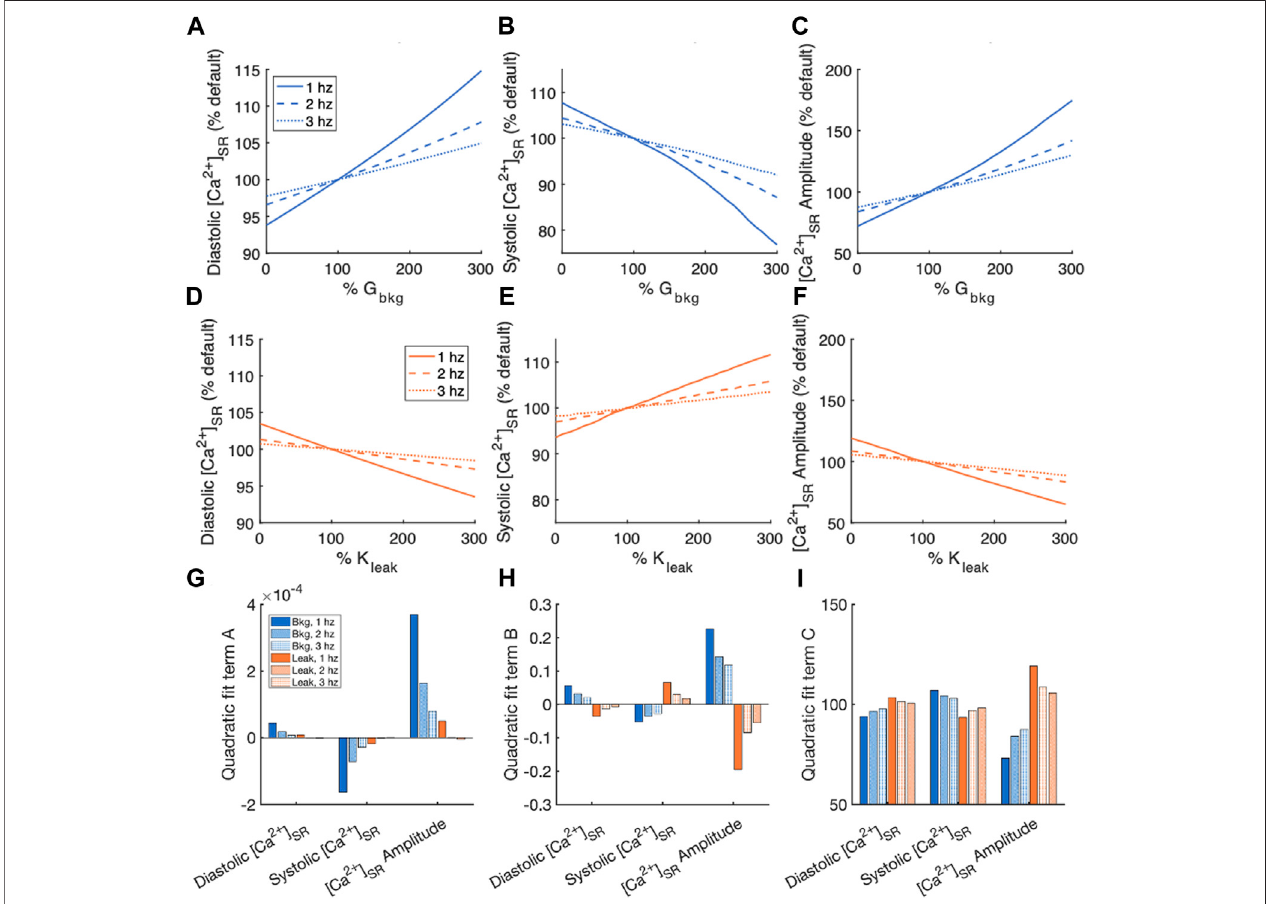
FIGURE 6 | Summary of effects of modulating G bkg or K leak independently on [Ca 2+ ] SR . Sensitivity analyses of modulating G bkg on measurements of (A) diastolic [Ca 2+